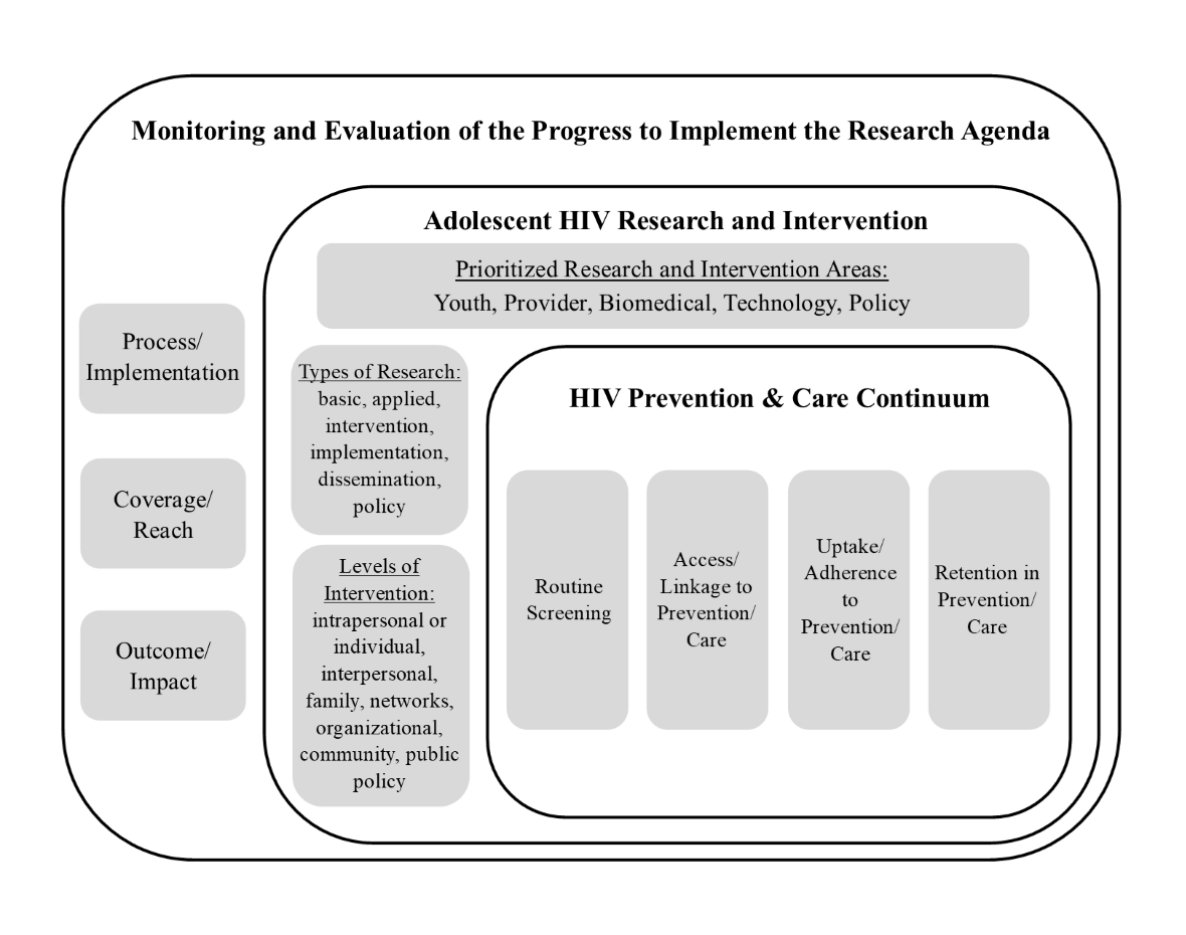
Figure 2. A nested model of the research needed to defeat the rising HIV epidemic among adolescents and young adults in the United States. This model includes the primary targeted outcomes to achieve reductions in HIV among youth at high risk and viral suppression among youth living with